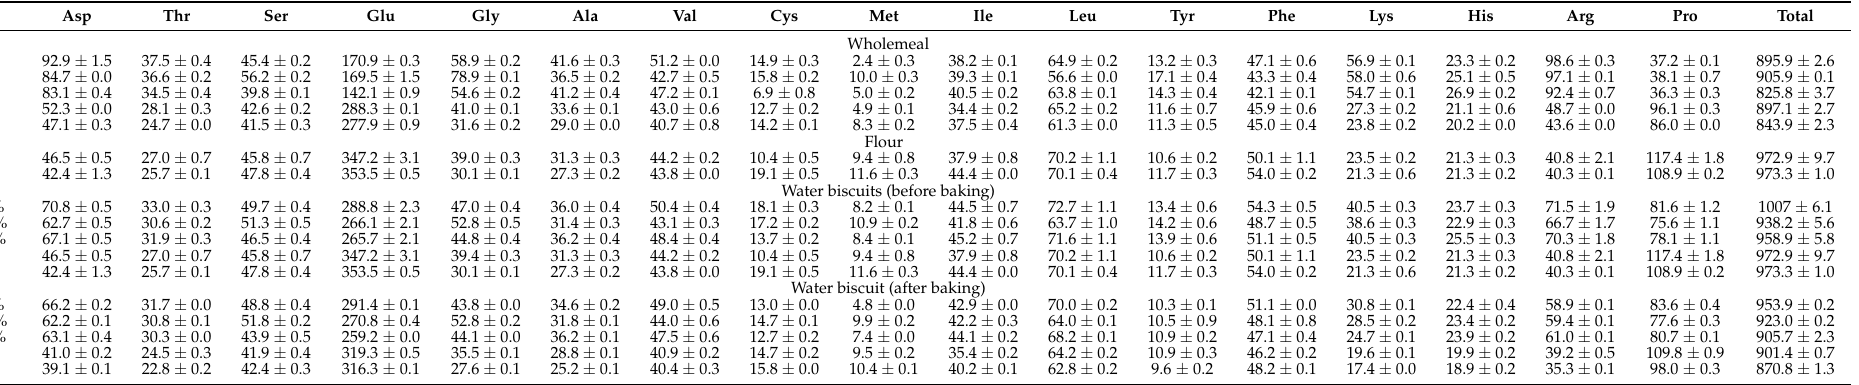
Table 2. Amino-acid composition (g/kg protein) of wholemeals, refined flours, and water biscuits before (theoretical) and after baking. BK, buckwheat; AM, amaranth; QU, quinoa; BW, bread wheat cv. Bramante; EI, einkorn wheat cv.